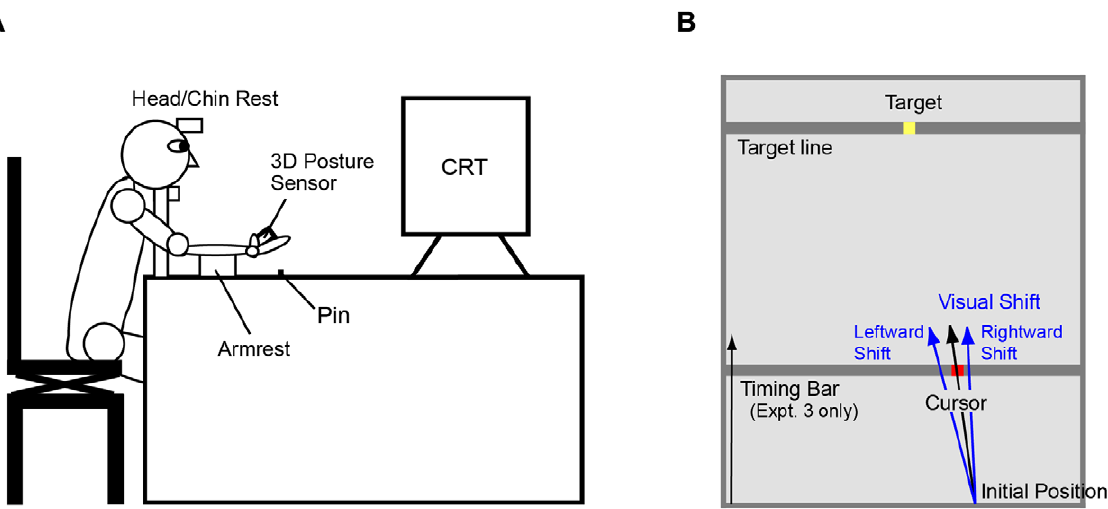
Figure 5. Experimental Setup. A: Subjects were seated facing a tangent 21-inch color CRT monitor with their heads restrained by a chin rest. Subjects put their right arms on an armrest with the right palm upturned and gripped a 3D posture sensor. Subjects were not able to observe their own movements. The 3D posture sensor measured Euler angles of subjects’ wrist movements. The pitch angle was referred to as the flexion angle and used to trigger the cursor movement, while the roll angle was referred to as the pronation/supination angle and determined the direction of cursor movement.B: The diagram shows the display on the CRT monitor. The area of the task field was 675 6 550 pixels. The target appeared on the target line, located 650 pixels from the bottom of the monitor. The initial position of the cursor was 100 pixels to the right of the bottom center of the monitor, and cursor movement was initiated by flexion movement of the wrist. The direction of cursor movement was controlled by the pronation/ supination angle, but the vertical velocity was fixed throughout the experimental session. Visual displacement was introduced by rotating the direction of cursor movement and, as a result, the position of the cursor endpoint was displaced in a horizontal direction. Note that in Experiments 1 and 2, the cursor was displayed only at the target line (i.e., impact position), although it was displayed from the initial position to the impact position in the practice session. In Experiment 3, the cursor was not displayed; instead, a timing bar was presented that indicated the vertical position of the